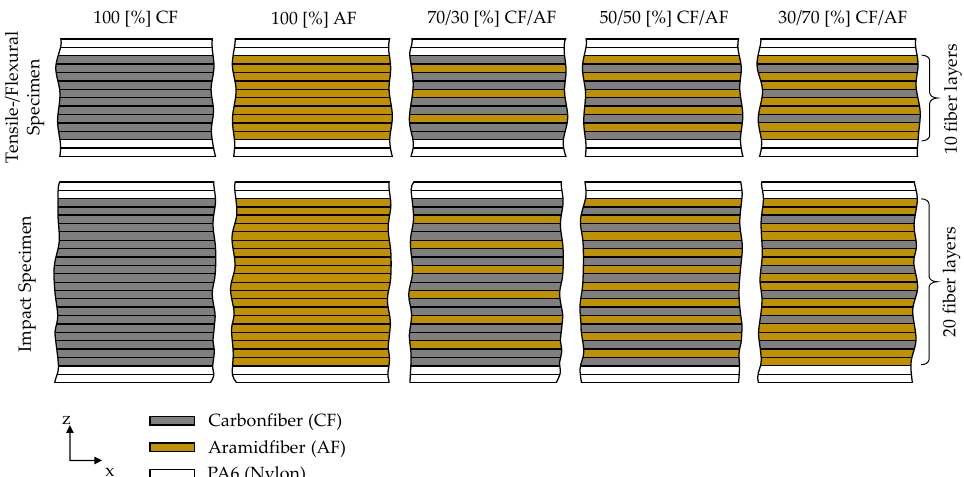
Figure 5. Schematic layer configuration of the tensile and flexural specimens with the used mixing ratios of carbon and aramid fibers.